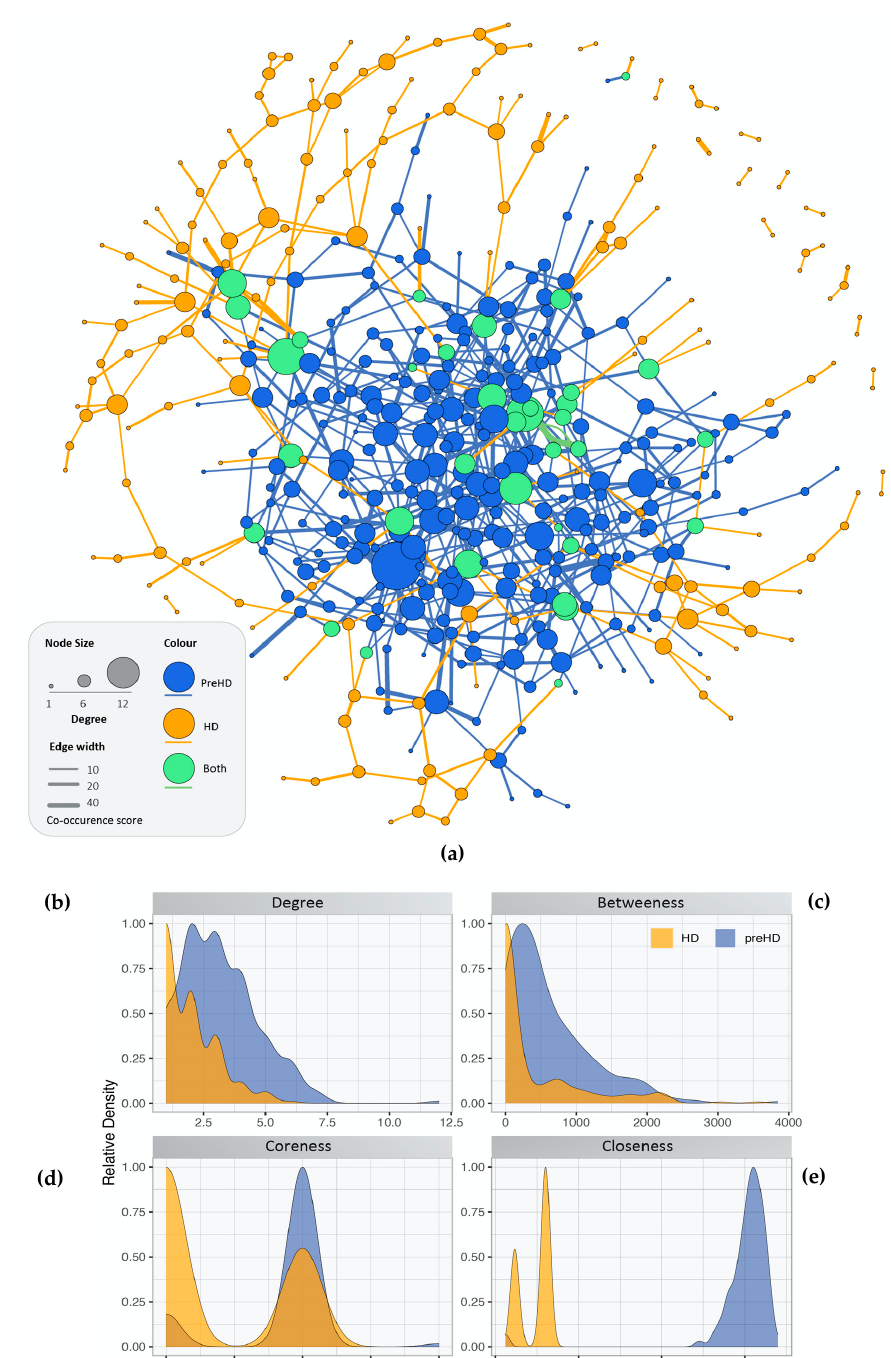
Figure 1. Network topological analysis of the gene co-expression. ( a ) Gene co-expression networks for controls versus pre-symptomatic and controls versus symptomatic HD. Blue nodes represent: the genes involved in pre-symptomatic HD, orange nodes represent: the genes involved in the symptomatic HD stage and green nodes represent the genes which appear in both HD networks. Edge colour represents co-expression in the respective groups (either or both HD stages) while edge thickness represents co-occurrence score ( b – e ) Distribution of the calculated centralities for the pre-symptomatic and symptomatic HD networks, i.e., ( b ) Degree ( c ) Betweenness ( d ) Coreness and ( e )